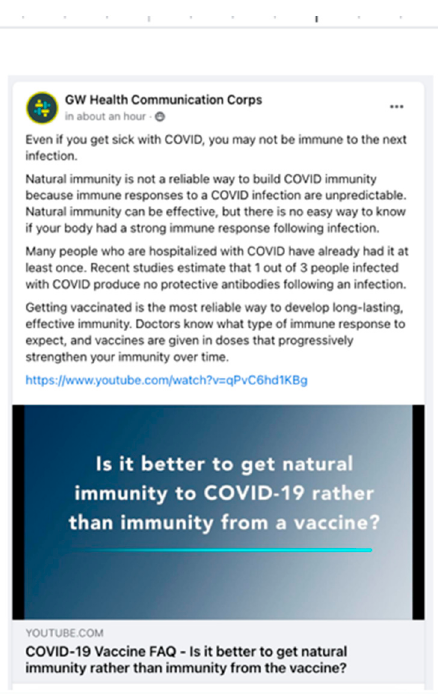
Figure 3. Sample